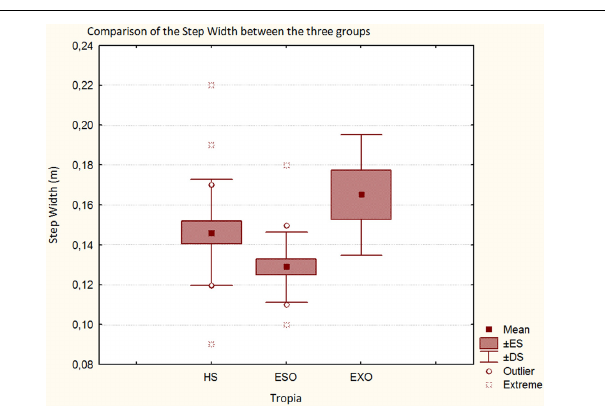
FIGURE 2 | Step length in HS, in patients with ESO and in patients with EXO.